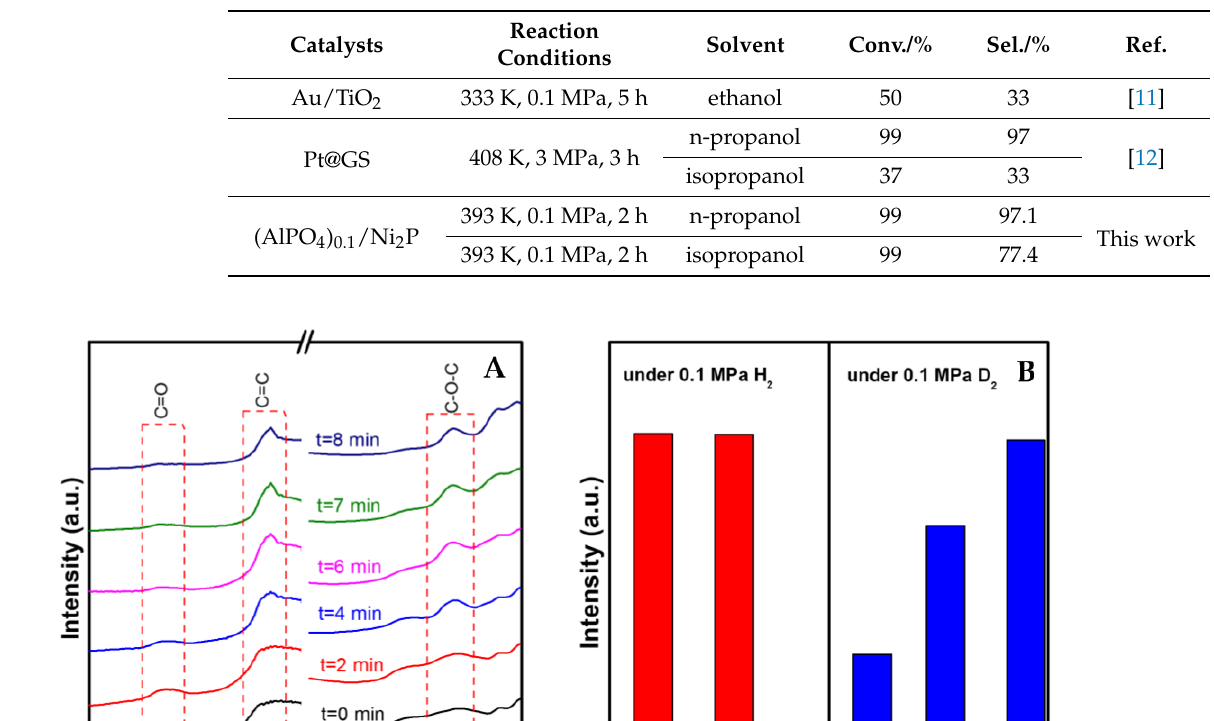
Table 2. Comparison of performance of different catalytic systems for hydrogenation transformation of cinnamaldehyde to cinnamyl alkyl ether in alcohol.